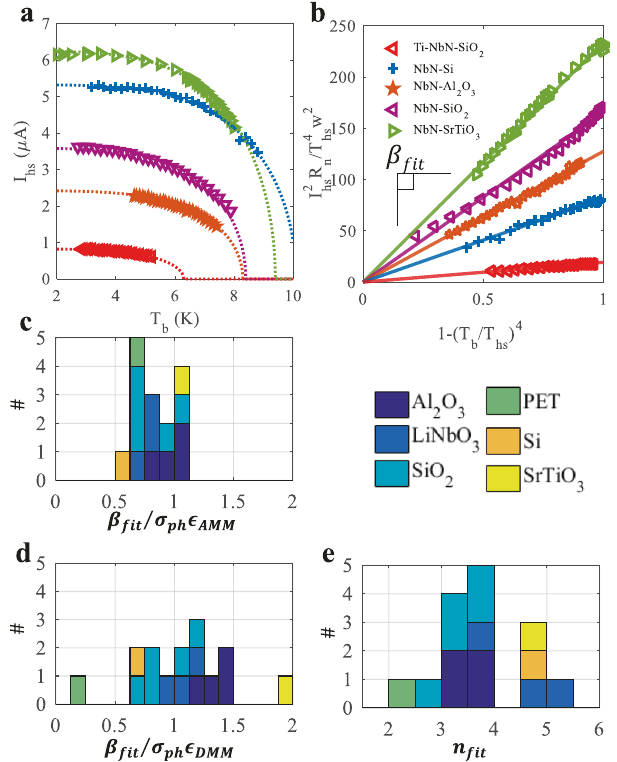
(cid:1) (cid:3) (cid:5) (cid:6) . d Histogram of (cid:1) (cid:3) while